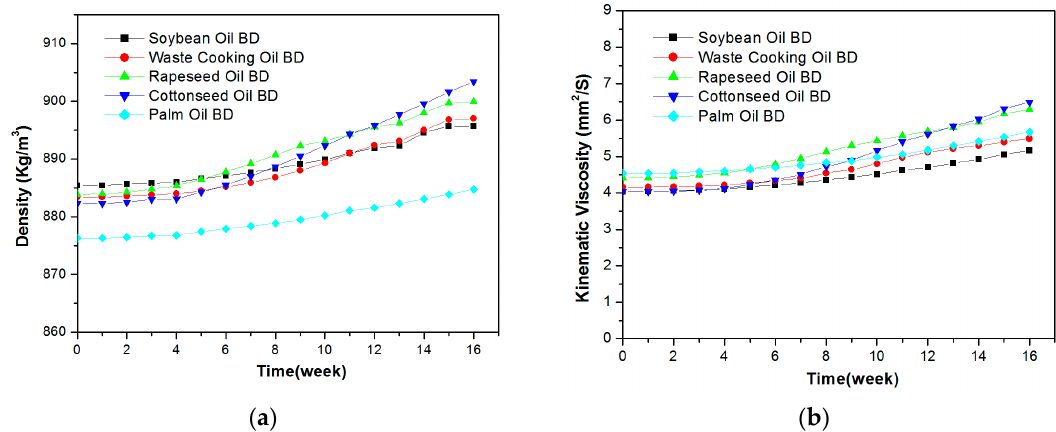
Figure 4. Change in ( a ) density and ( b ) kinematic viscosity of BDs during accelerated oxidation.